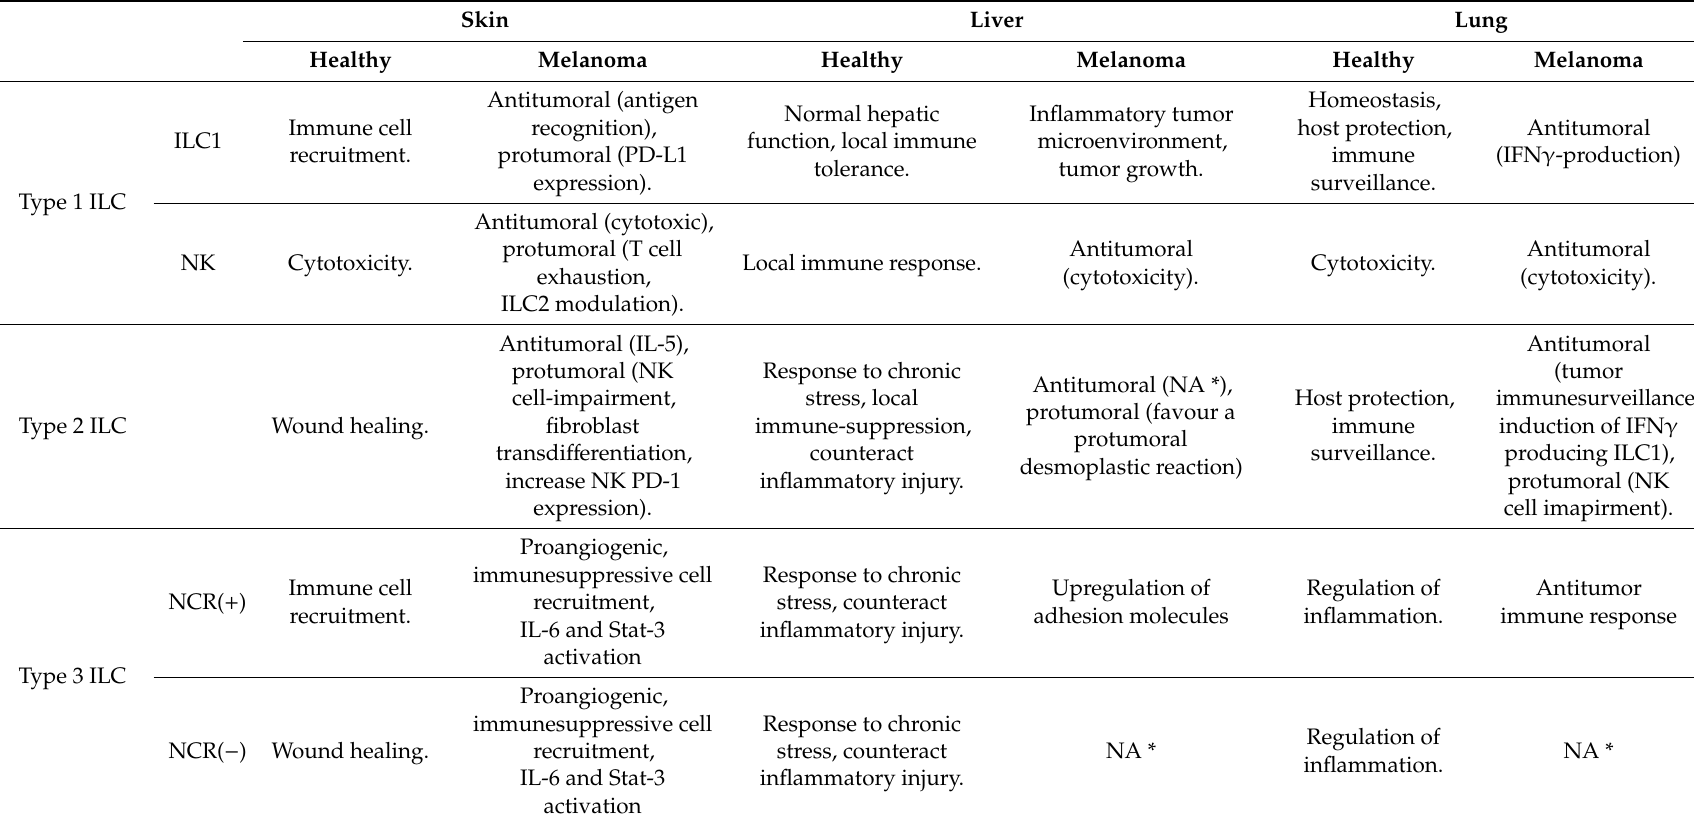
Table 2. Functions of ILC types within a normal and tumor microenvironment during melanoma